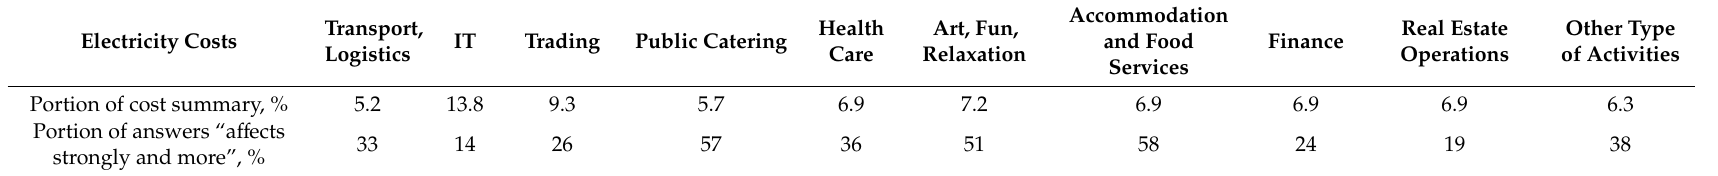
Table 5. Branch assessment of the level of influence of cost items